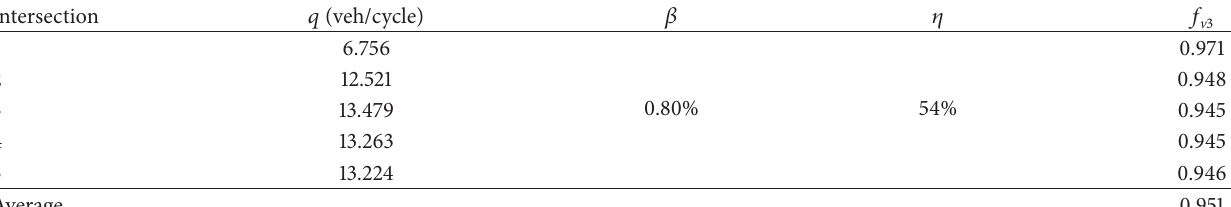
Table 12: Adjustment of lane saturation flow rate for the lane